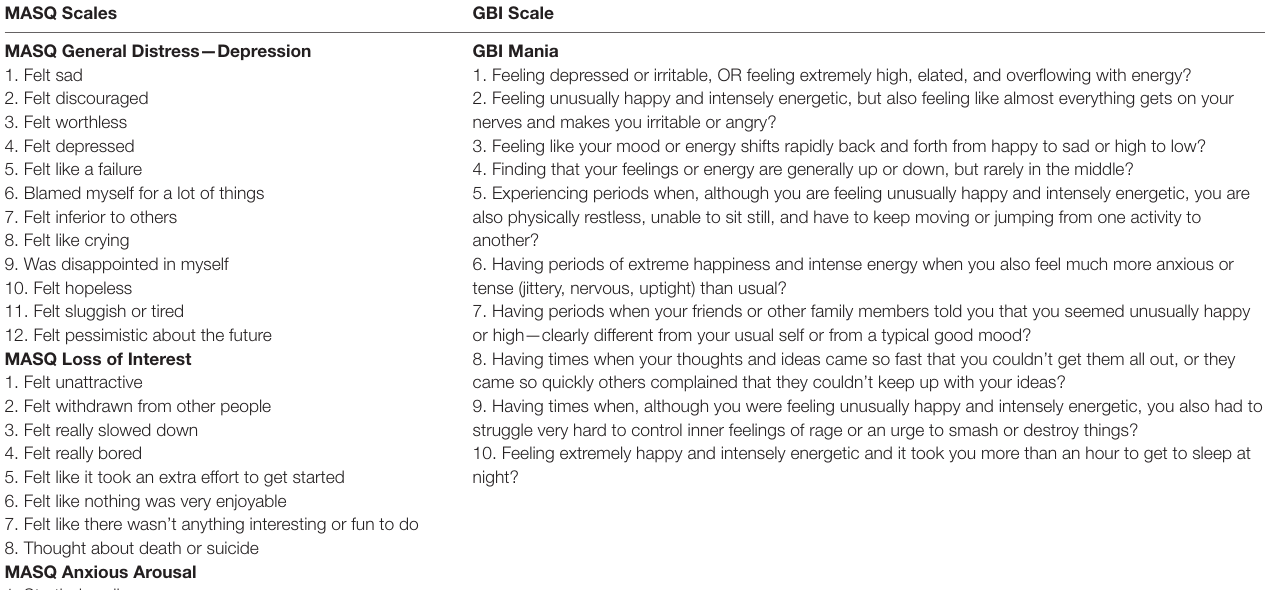
TABLE 3 | Items from the MASQ and GBI scales. MASQ Scales GBI Scale MASQ General